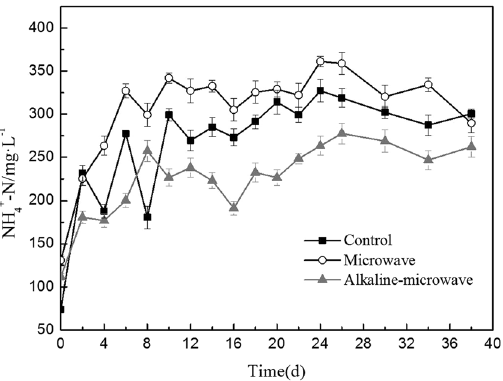
Figure 4. Changes of ammonium nitrogen during the anaerobic digestion after different